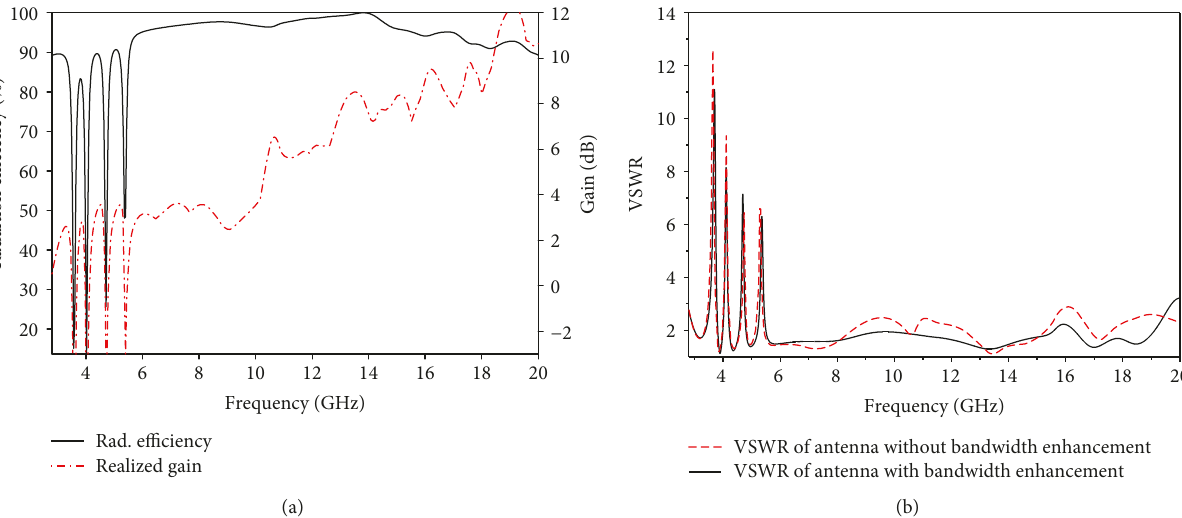
Figure 7: (a) Simulated antenna gain and radiation e ffi ciency and (b) simulated VSWR plot of the UWB antenna with ground notch versus without notch for bandwidth